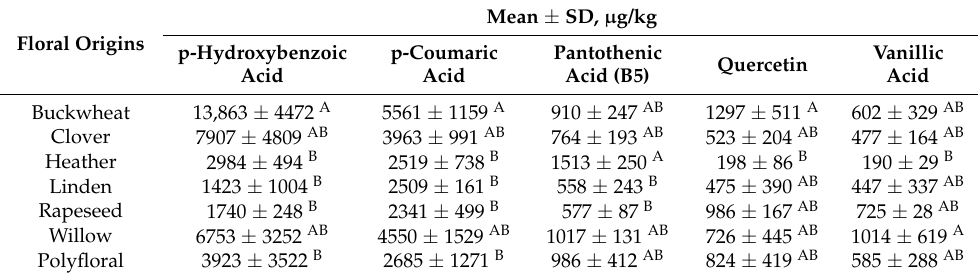
AB —results marked with a different superscript letter are significantly different using ANOVA one-way Tukey test ( p < 0.05). Letter “A” indicates affiliation to a group with higher means and letter “B” indicates affiliation to a group with lower means, while “AB” shows affiliation for both